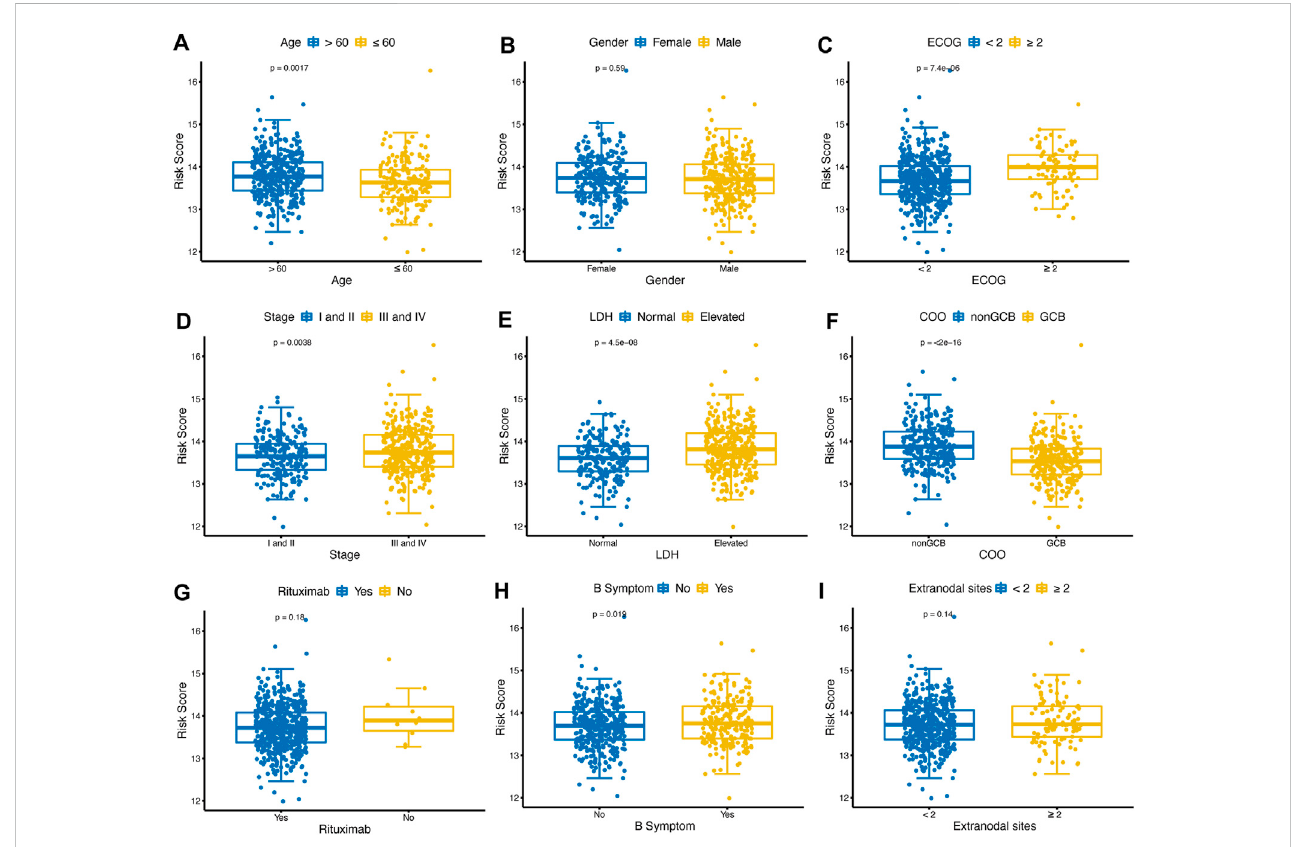
FIGURE 5 Distributionofglycolyticriskscoreindifferentclinicalcharacteristics.Comparisonoftheglycolyticriskscoredistributionbetweendifferentsubgroupsof age (A) , gender (B) , ECOG-PS (C) , stage (D) , LDH (E) , COO (F) , rituximab (G) , B symptoms (H) , and extranodal sites (I) . ECOG-PS, Eastern Cooperative Oncology Group performance status; LDH, lactate dehydrogenase; GCB, COO, cell of